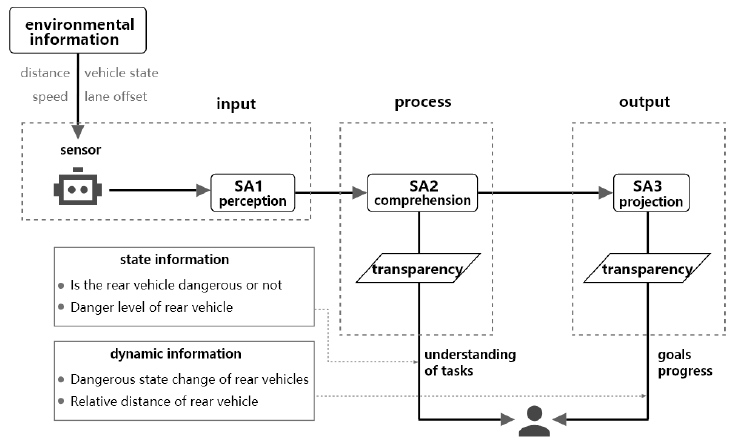
Figure 2. Task process transparency design model based on shared situation awareness.